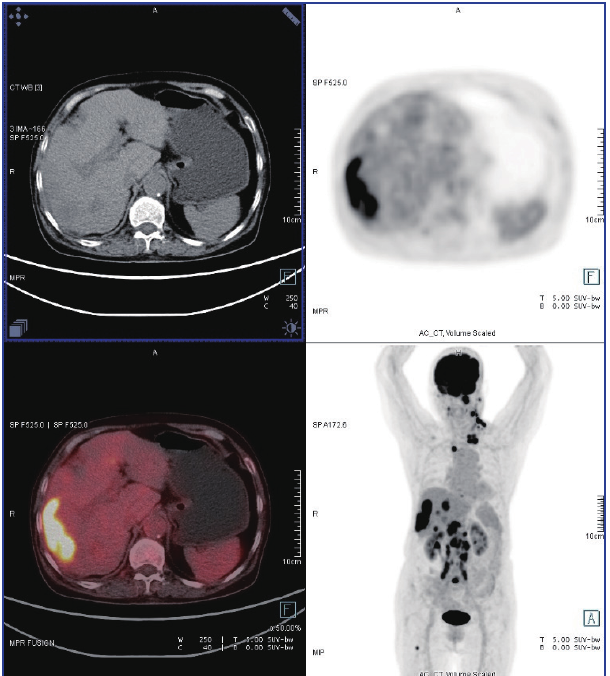
Figure 3 PET-CT. Multiple masses were detected in the liver, while the nasopharynx and lung were normal. Lymphatic Metastases were found in left cheek, left pharynx, bilateral neck, left supraclavicular area, right cardiodiaphragmatic angle, first hepatic hilum, abdominal periaorta, and bilateral common iliac periaorta. Skeletal metastases were also found in the right acromion, third thoracic vertebra, fifth lumbar vertebra, and right